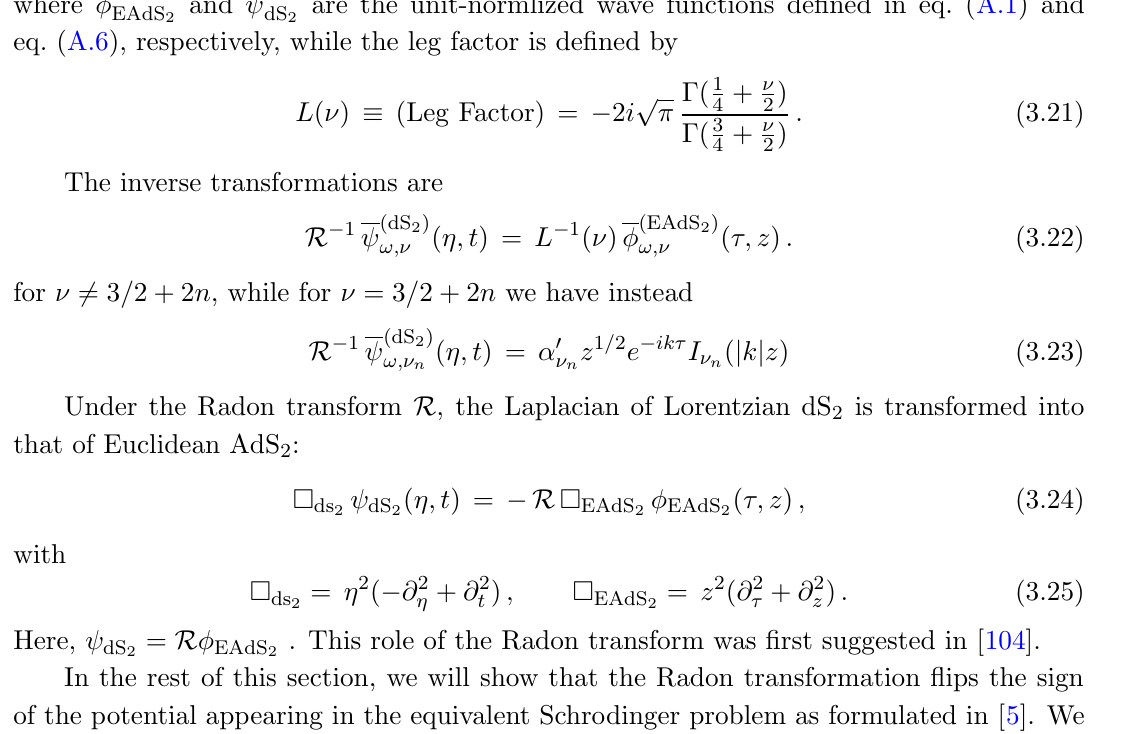
has bound states and scattering states. On the other hand, dS 2 has only scattering AdS 2